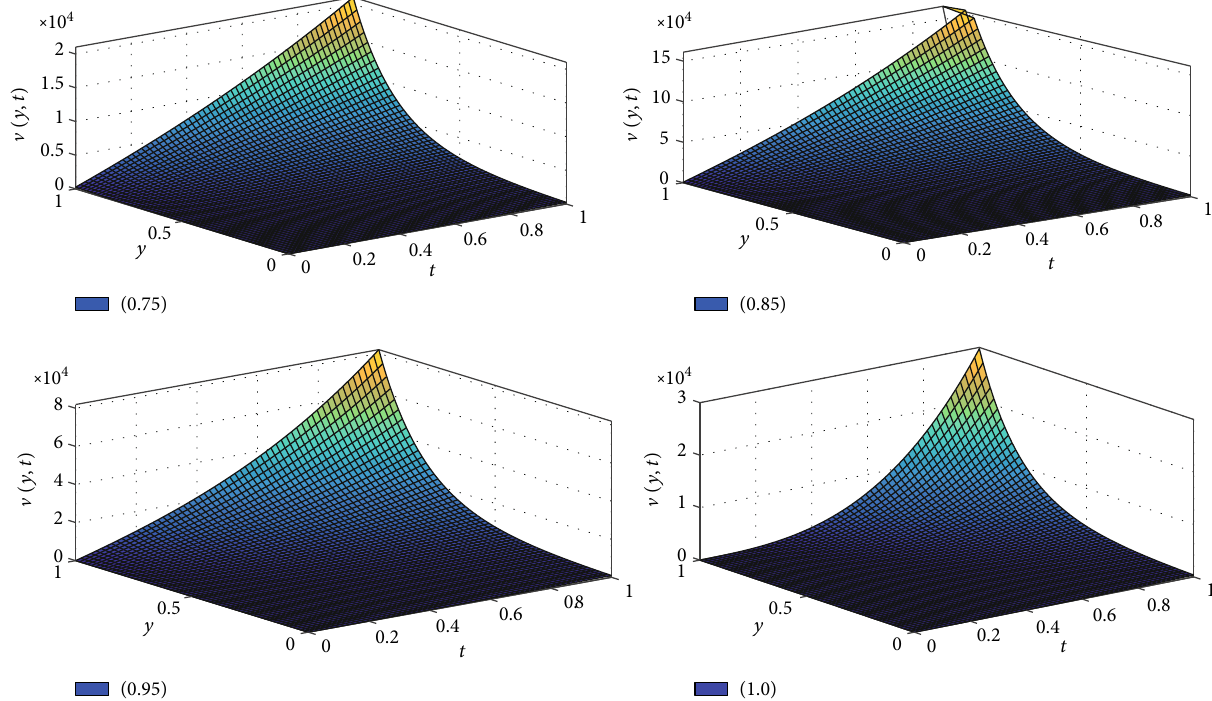
Figure 4: Surface plots of the resultant solution up to four terms at di ff erent values of γ for Example 4.